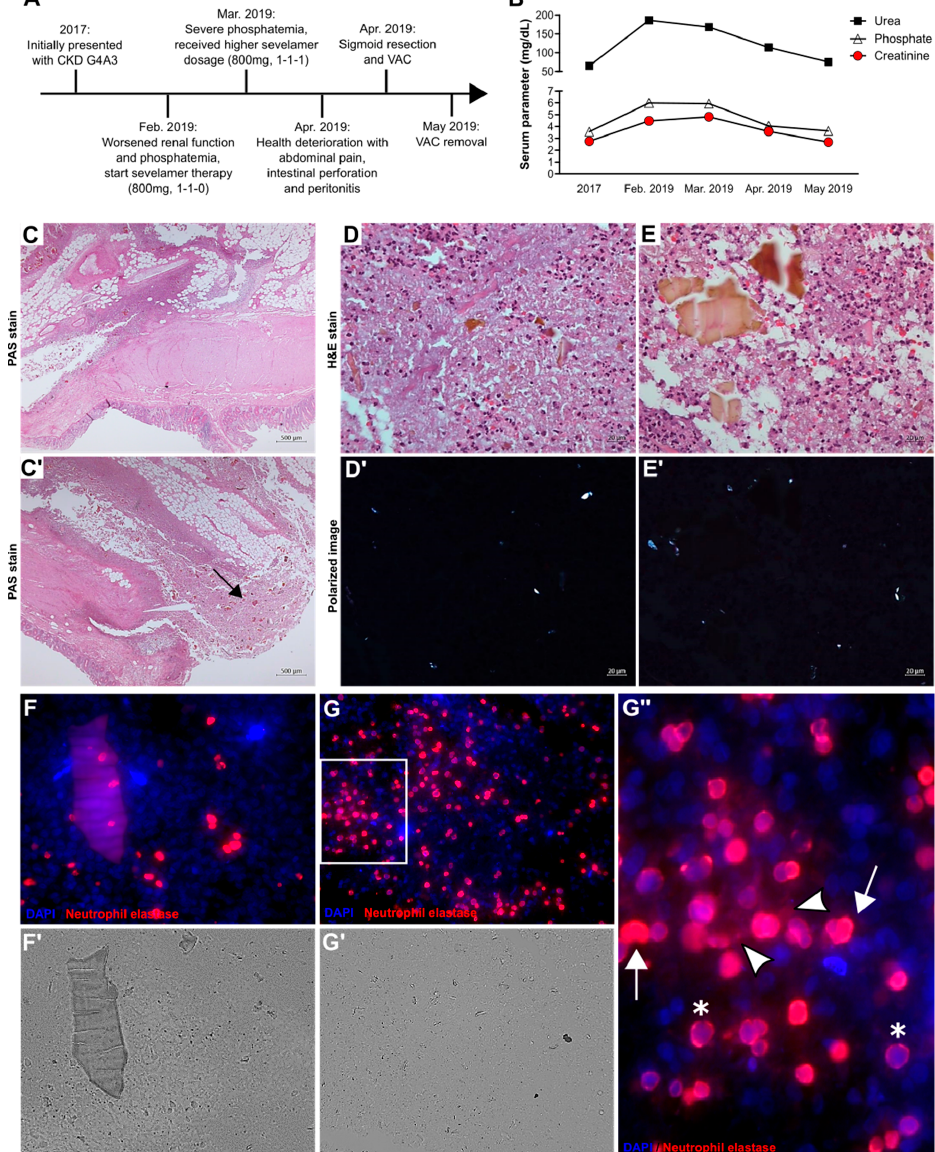
Figure 1. Sevelamer crystal-induced intestinal necrosis associated with neutrophil extracellular trap formation. ( A ) Clinical course of a patient (67 years of age) with chronic kidney disease (CKD). The intake of sevelamer due to phosphatemia and the prolonged decline in kidney function caused intestinal necrosis, perforation, and peritonitis. Surgery with vacuum-assisted closure (VAC) was needed and the patient recovered. Sevelamer therapy was discontinued. ( B ) Serum urea, phosphate, and creatinine levels over the clinical course of the same patient. ( C , C’ ) Periodic acid-Schi ff (PAS) staining of sections of the colonic resection specimen from the patient. The arrow indicates sevelamer crystal deposits. Magnification 25 × . ( D , E ) Hematoxylin and eosin (H&E) staining of the same resection specimen showing necrotic lesions, infiltration of cells, fibrosis, and massive sevelamer crystal deposits. Only small sevelamer crystals are birefringent under polarized light but not big crystal masses ( D’ , E’ ). ( F , F’ , G , G’ ) Fluorescence ( F , G ) and light ( F’ , G’ ) microscopy of the same colonic resection specimen stained with 4 (cid:48) ,6-diamidin-2-phenylindol (DAPI) (nuclei / DNA, blue) and neutrophil elastase to identify neutrophil extracellular trap (NET)-like structures, red. ( G” ) A close-up representative image indicating decondensed non-aggregated NETs (white arrowheads), di ff use NETs with decondensed nuclei (DNA) (white arrows), and neutrophils with intact DNA / nuclei